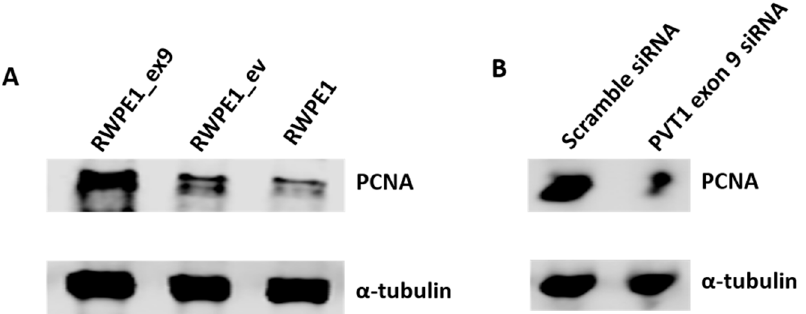
Figure 3. PVT1 exon 9 regulates the expression of proliferating cell nuclear antigen (PCNA). ( A ) Expression of PCNA is upregulated with PVT1 exon 9 overexpression and ( B ) downregulated with PVT1 exon 9 silencing. Western blotting experiments were performed two separate times, image presented is